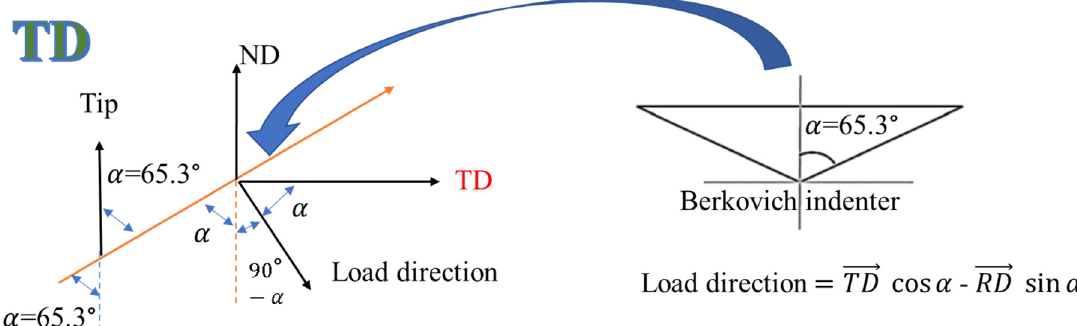
Figure 10. Direction of the load normal to the Berkovich indenter tip surface where the major axis of the indent was aligned along the TD, which was used to calculate the critical resolved shear stress (CRSS) (or Schmid factor) for the Cu layer (Table 3). Similar calculations were performed for RD. The angle ( α ) is the half-angle of 65.3° measured from the axis to one of the pyramid flats of the Berkovich tip. Table 3. Schmid factor to analyze the activated slip systems along the TD and RD for the Cu layer.